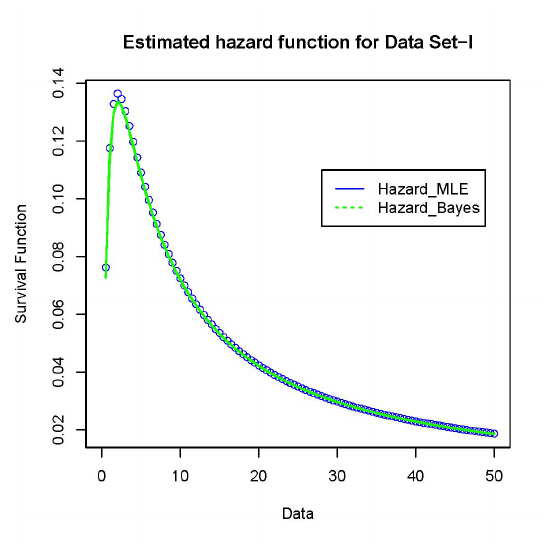
Figure 4 – Estimated hazard function plot for the data set-I.